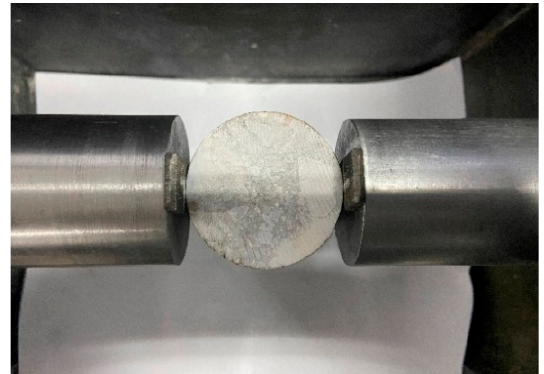
Figure 5. The picture of specimen installation.